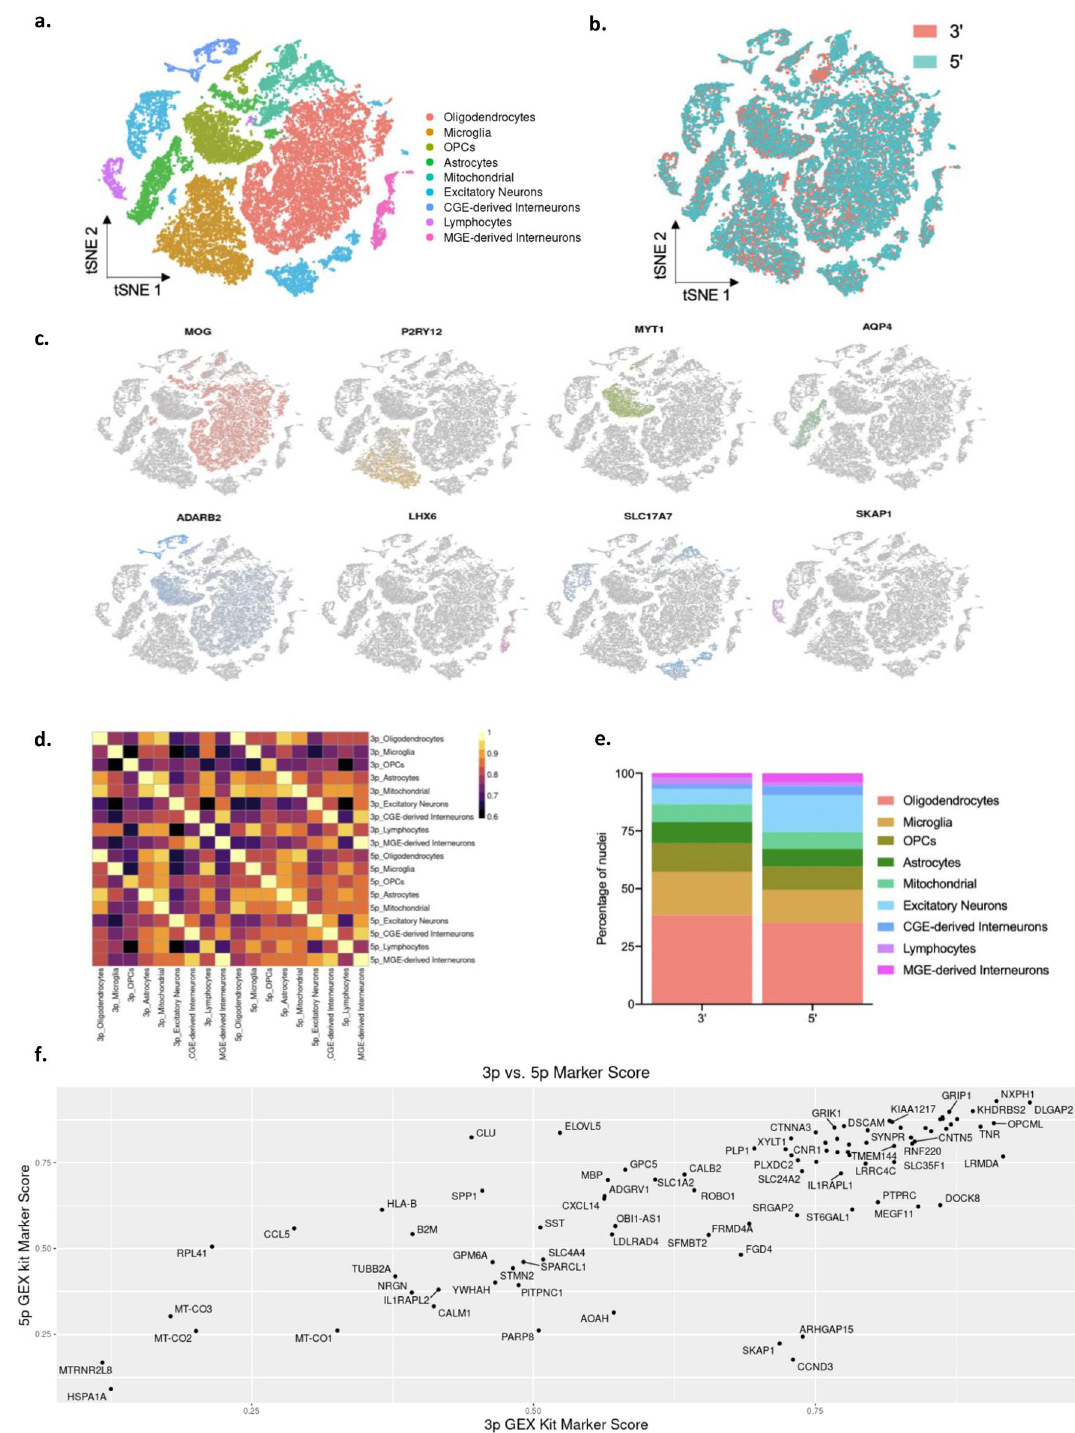
Figure 3. Similar cell type distribution and proportion. ( a ) Nuclei integrated together from all six libraries clustered into nine cell type clusters. ( b ) Distribution of nuclei across clusters was similar for those sequenced with the 5’ or the 3’ kits. ( c ) Canonical cell type markers used to identify the nine cell type clusters. ( d ) Correlation matrix of gene expression by kit for each cell type. ( e ) Percentage of nuclei in each cell type cluster by kit. ( f ) Marker gene efficacy is similar for each capture